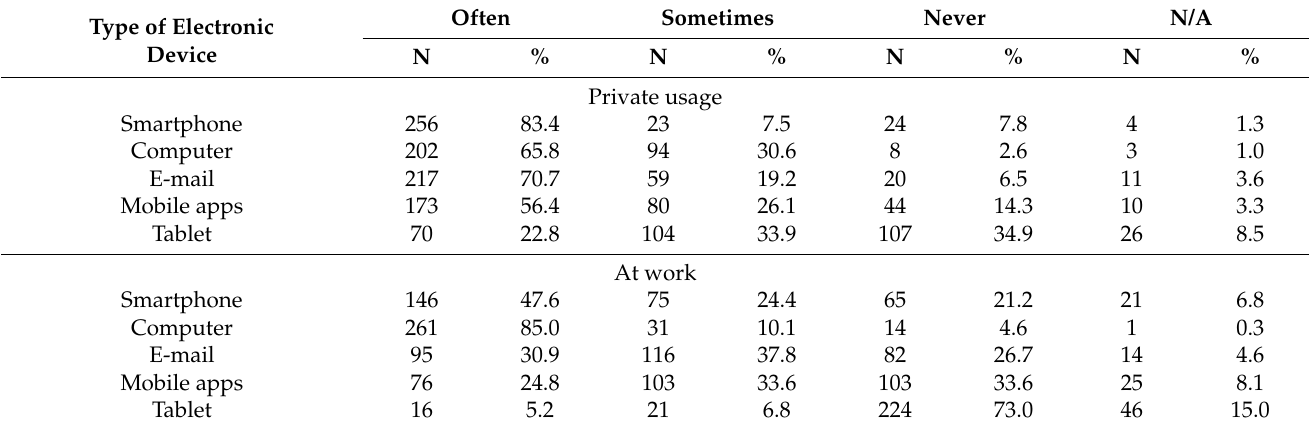
Table 1. The frequency of the electronic devices usage by physicians in private and professional life.